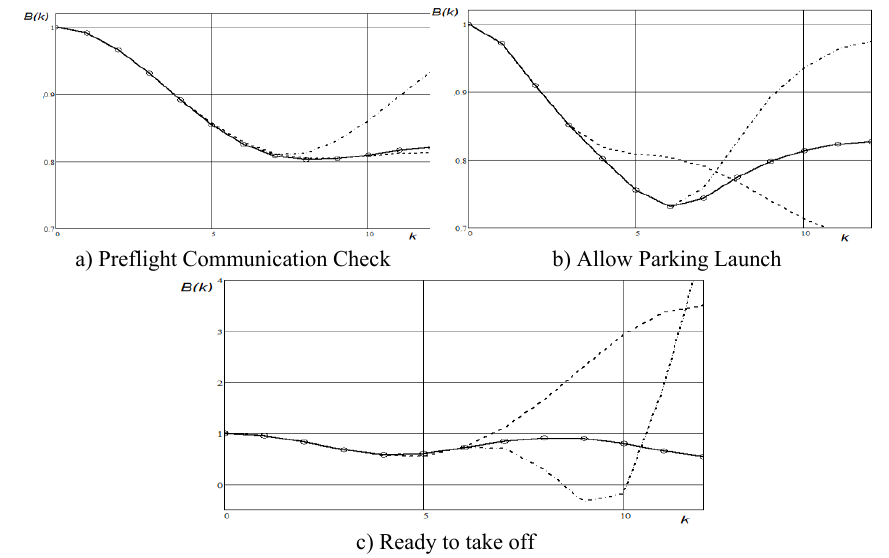
Fig. 4 Approximation of CF using autoregressive